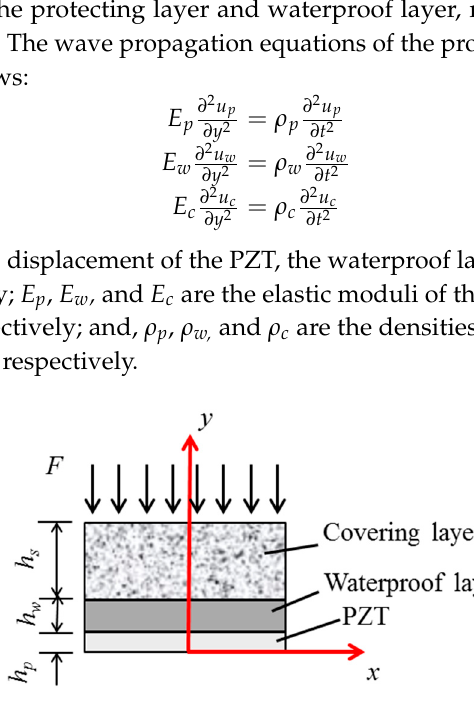
Figure 2. A half model of the embeddable PZT transducer.